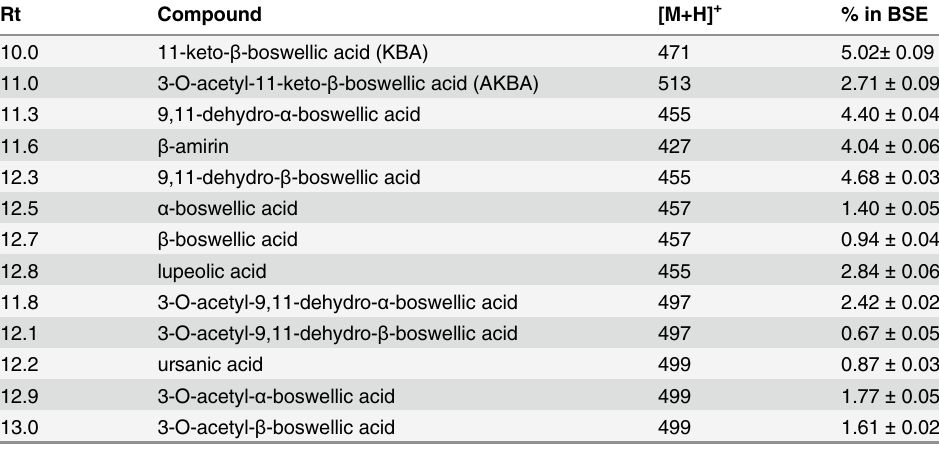
Table 1. Main triterpene content in the BSE: retention time (Rt), adduction ion ([M + H] + , formed by the interaction of the molecule with a proton), and percentage